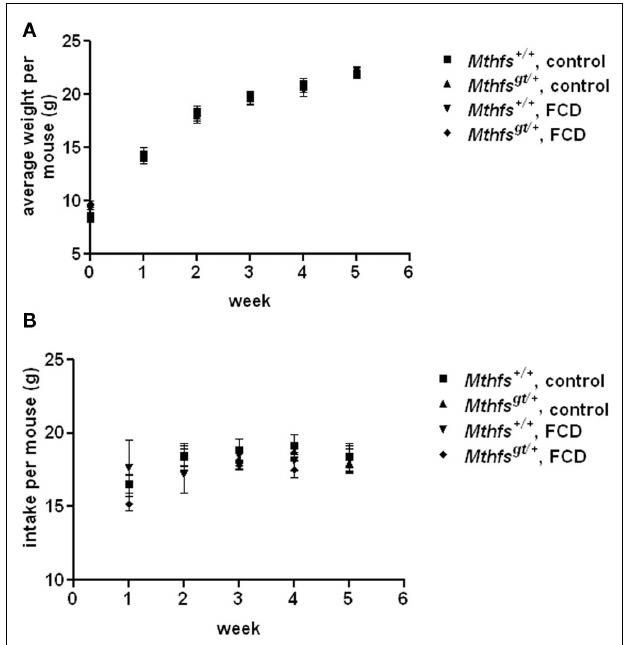
FIGURE 3 |Weight gain and food intake in Mthfs + / + and Mthfs gt/ + mice fed either control diet (AIN-93G) or folate-choline deficient diet (FCD; AIN-93G lacking folate and choline) for five weeks. In both (A) weight gain per mouse and (B) intake per mouse Mthfs + / + on control diet is shown by squares; Mthfs gt/ + on control diet shown by triangles; Mthfs + / + on FCD shown by inverted triangles; Mthfs gt/ + on FCD shown by diamonds. Data is shown as the mean and standard deviation with n = 10 per group.